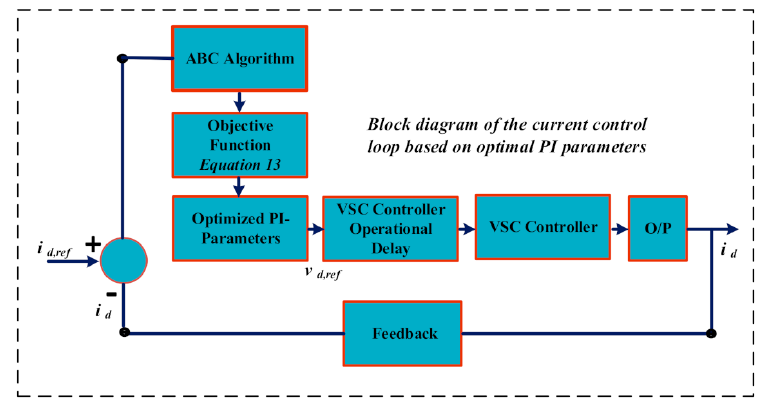
Figure 6. Procedure of ABC algorithm on P-I